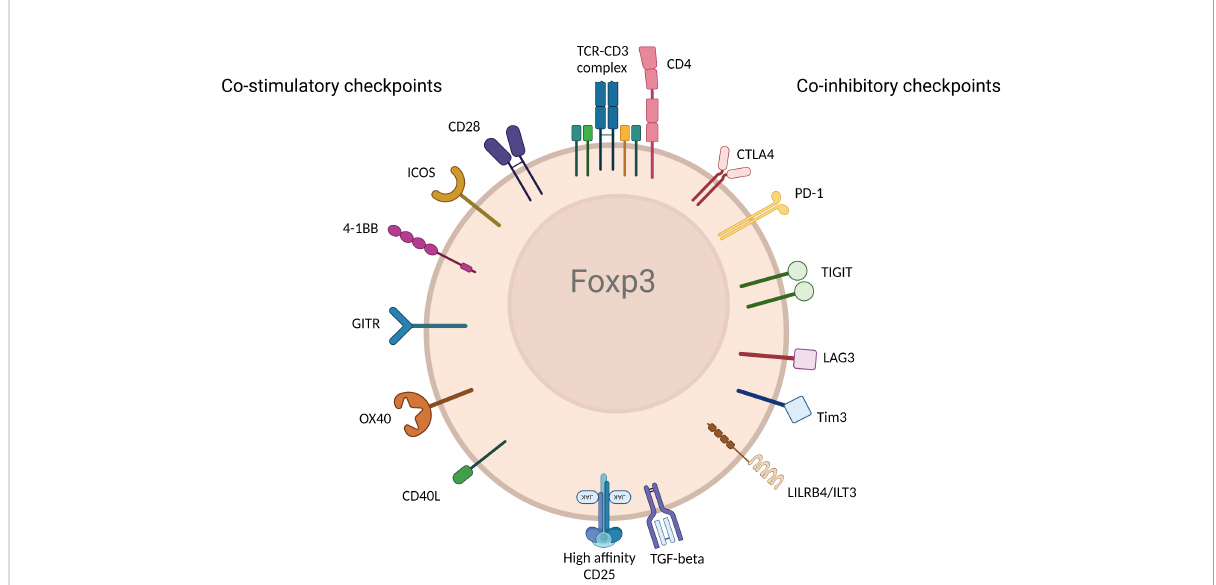
FIGURE 2 Immune checkpoint receptors expressed by Tregs. Various immune checkpoint receptors deliver unique signals to Tregs following engagement with their ligands expressed on APC and/or cells in tissue or diseased cells in different disease environments. The fi gure represents the most described co-stimulatory (left) and co-inhibitory checkpoints. (Created with